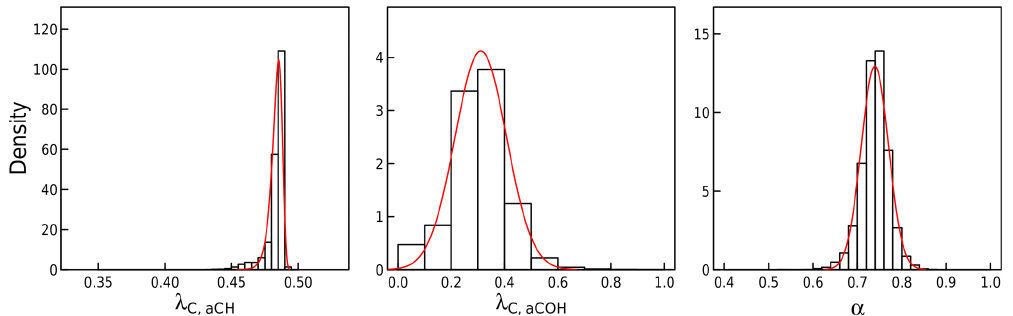
Figure 2. Prior distributions for λ C and α . Histograms are generated from estimates from subsets of molecules representing a combination of primary and secondary organic aerosols, and red lines are fitted parametric distributions (Weibull for λ C to capture asymmetry and normal for α